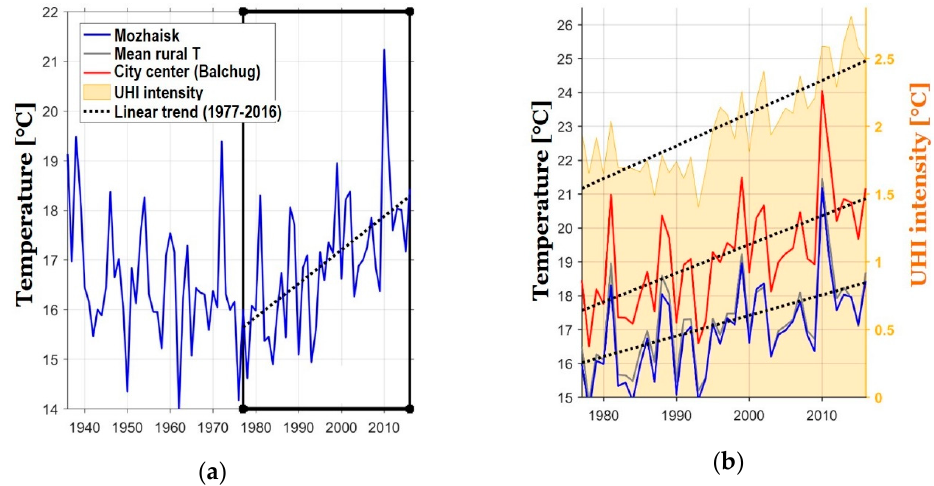
Figure 2. Dynamics of the average summer air temperature at the Mozhaisk station between 1936 and 2016. ( a ); the dynamics of air temperature at Mozhaisk and Balchug stations and the average background temperature (averaged over the Naro-Fominsk, New Jerusalem, Klin, Dmitrov, Aleksandrov, Pavlovsky Posad, Kolomna, Serpukhov, Maloyaroslavets stations), and the heat island’s intensity, which is defined as the temperature difference between the station Balchug and average background values between 1977 and 2016. ( b ). Black dashed lines show linear trends for between 1977 and 2016. UHI is Urban Heat Island.